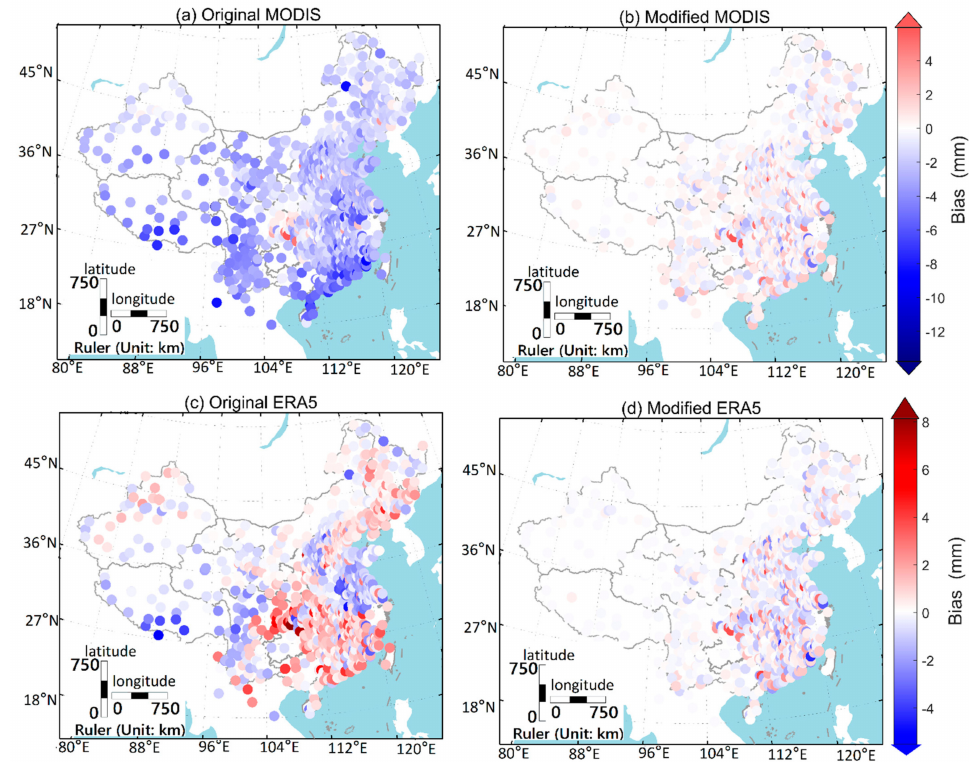
Figure 9. PWV biases at individual stations of the original MODIS (ERA5) PWV and the modified MODIS (ERA5) PWV.